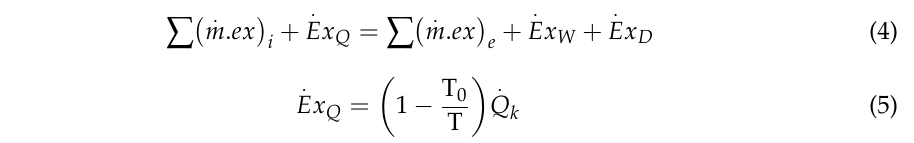
Table 2. The thermal efficiency can be calculated as [23]: